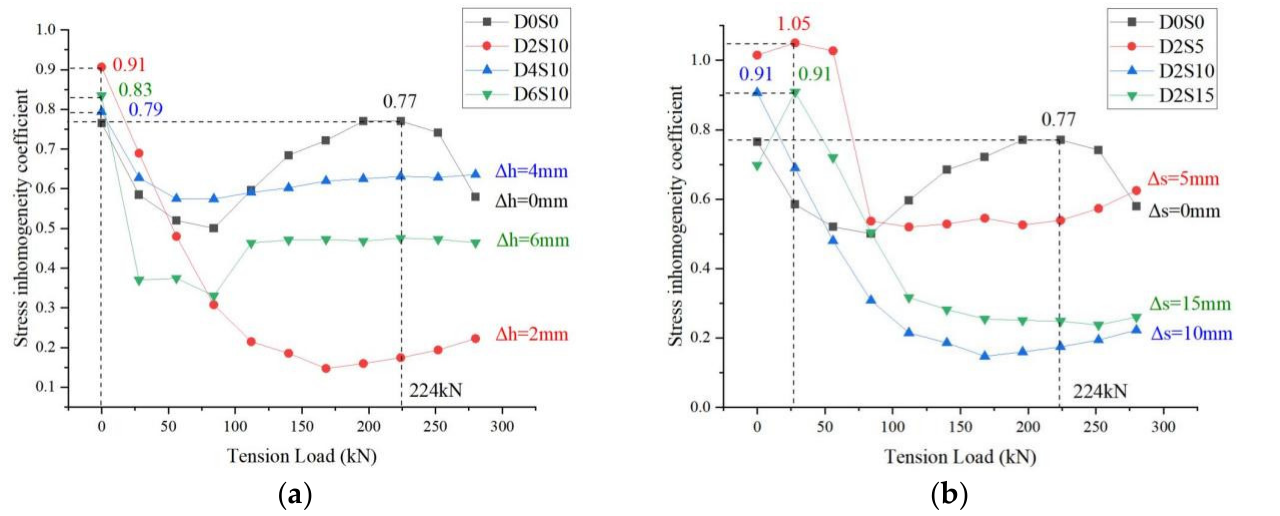
Figure 12. Variation curve of stress inhomogeneity coefficient: ( a ) η e of specimen group with different groove depth; ( b ) η e of specimen group with different groove